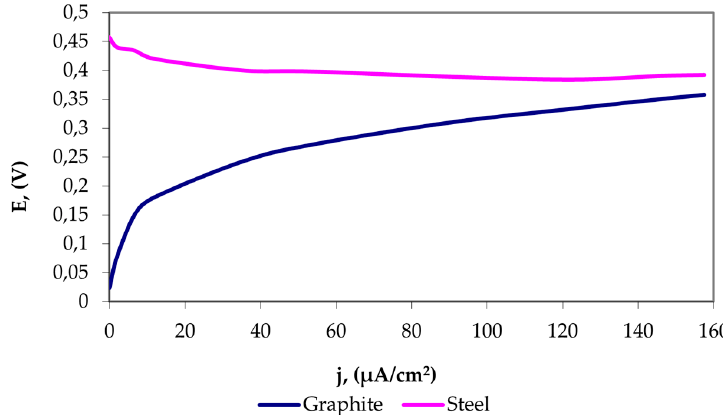
Figure 5. Corrosion diagram of a steel sample without protective coating.